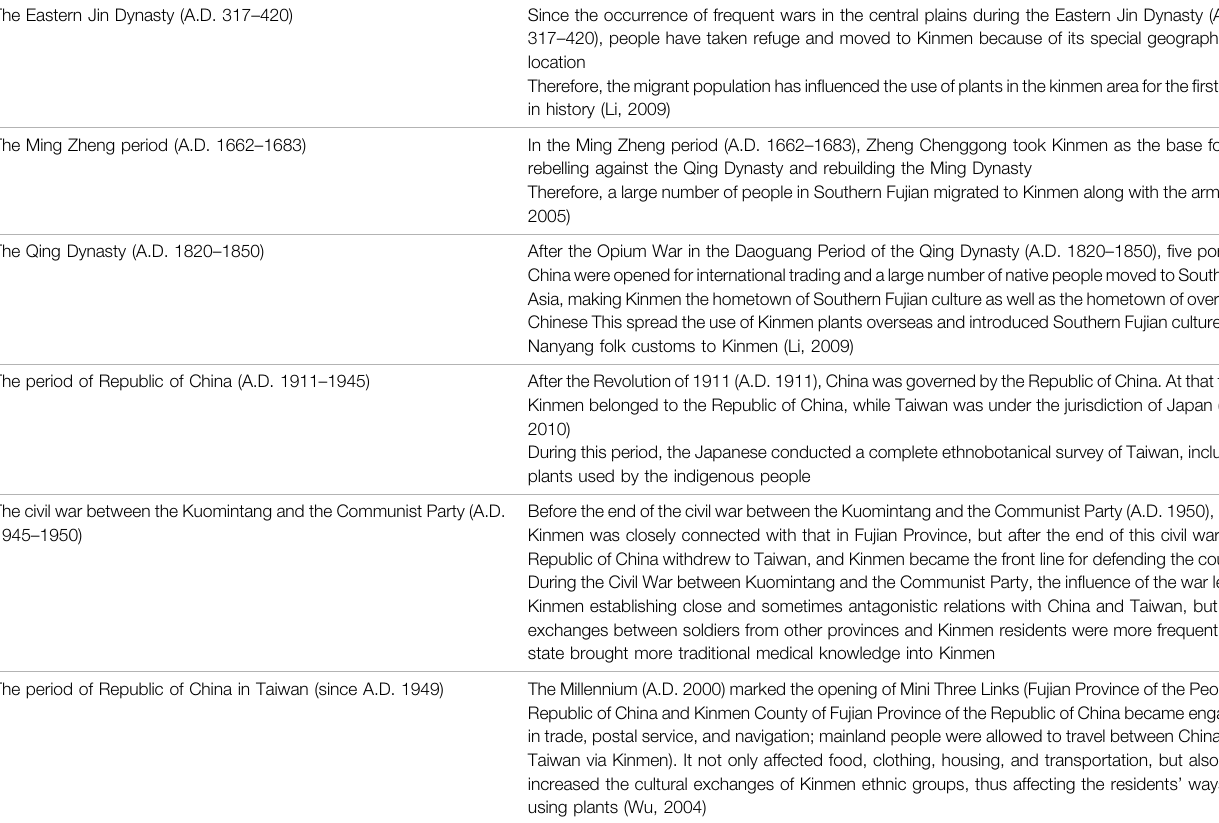
TABLE 1 | The important historical events that promoted ethnobotanical plant exchange in